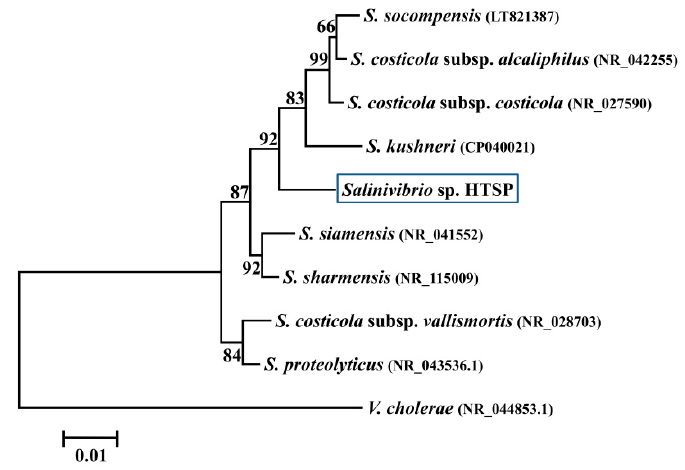
Figure 1. Phylogenetic tree based on 16S rRNA gene sequences (ca.1465 bp) using the neighbour-joining method. The bootstrap test (1000 replicates) is shown next to the branches. The GenBank accession number of each sequence is shown in parenthesis. V. cholerae is used as an outgroup.